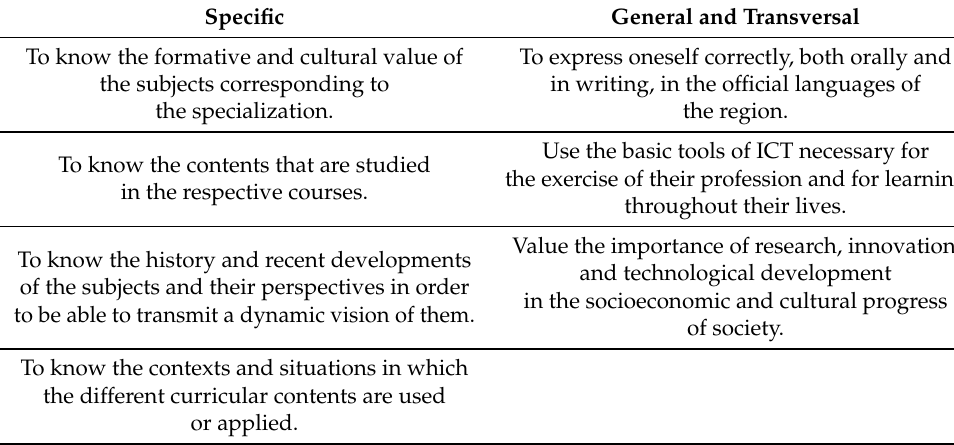
Table 2. Competences of the subject Technology in Secondary